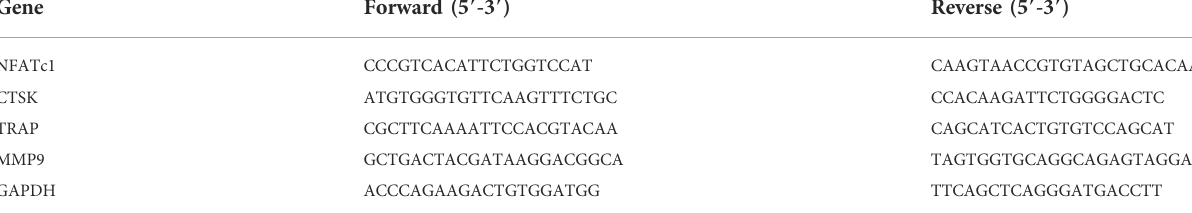
TABLE 1 Primer sequences used for quantitative real-time